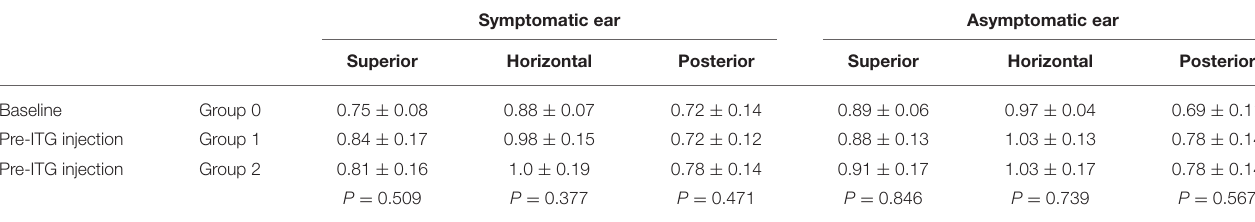
TABLE 2 | Mean VOR gain and standard deviation according to ear and canal stimulation by groups before treatment.